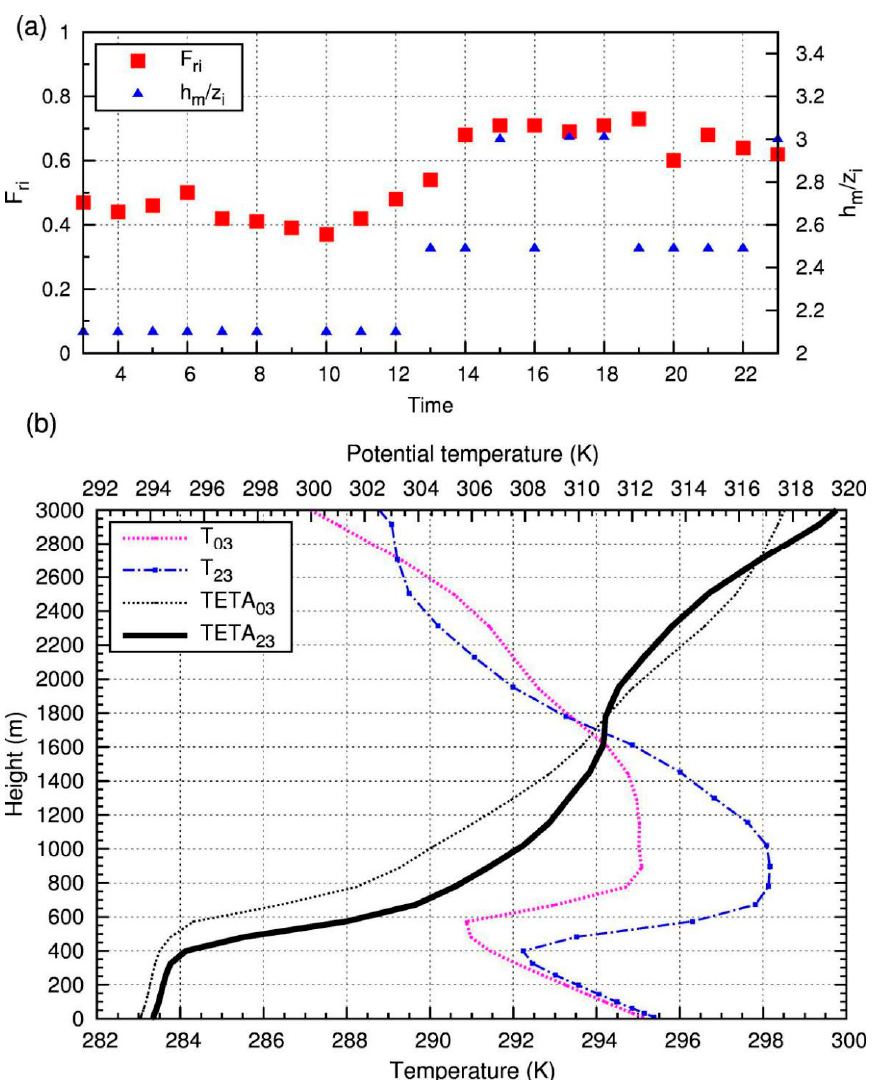
Figure 9. ( a ) Time evolution of Fr i and h m / zi on 7 August 2016. The computation of these parameters was based on AROME forecasts at point A50 (see its location Figure 1a). ( b ) Vertical profile of temperature (T) and potential temperature (TETA) at point A50, derived from the AROME forecasts, valid at 03 UTC and 23 UTC, on 7 August 2016.